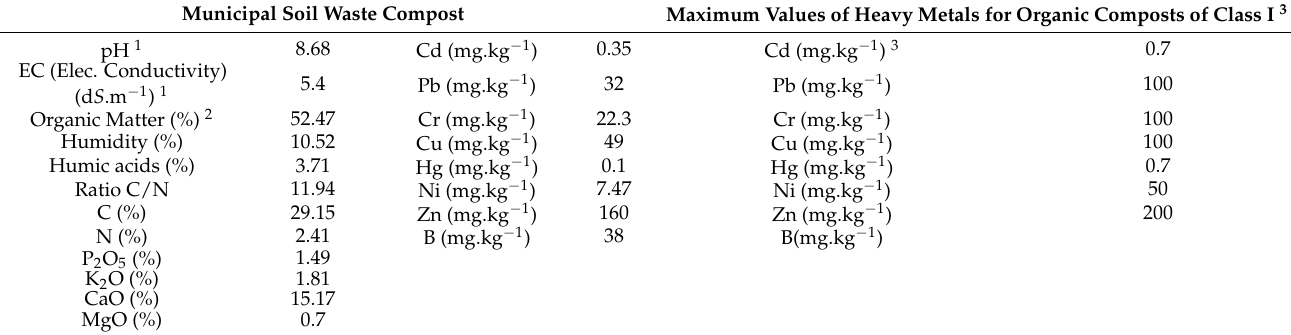
Table 2. Physicochemical characteristics of the municipal solid waste compost (MSWC) and maximum values of heavy metals in class I organic